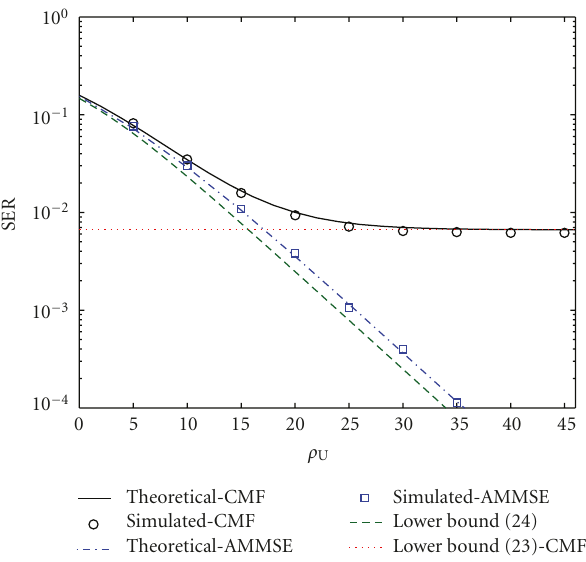
Figure 8: SER in CDMA downlink systems (BPSK, K = 20, P = 31, Gold codes).